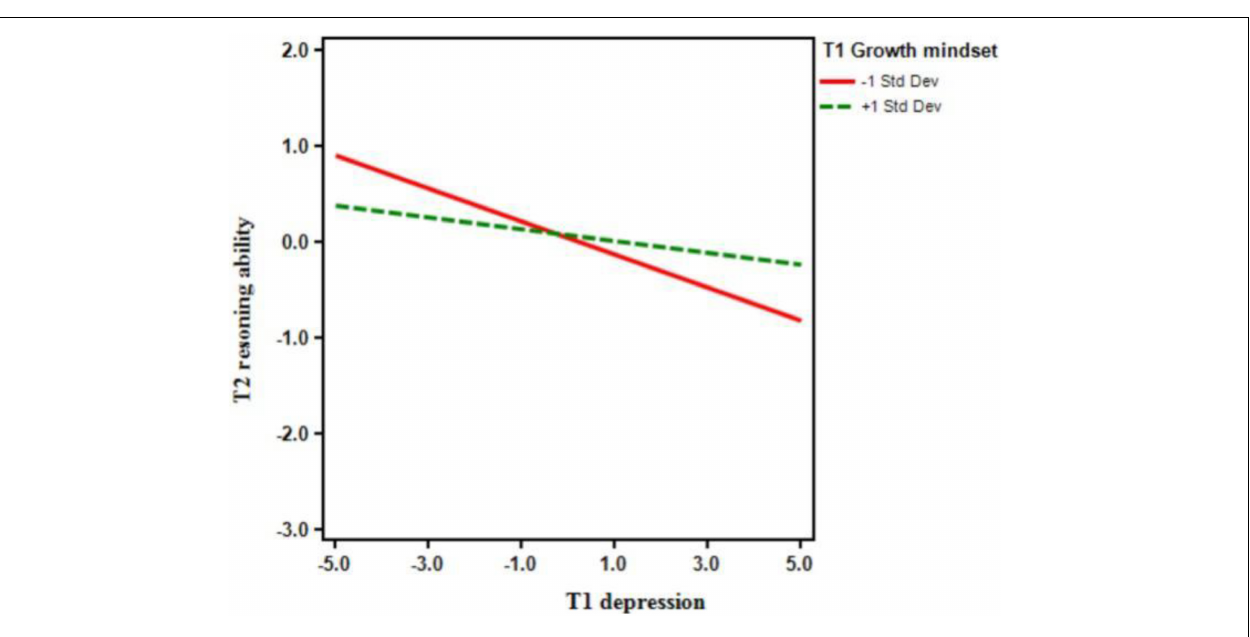
FIGURE 5 | The moderation effect of T1 growth mindset on the relationship between T1 depression and T2 reasoning ability in